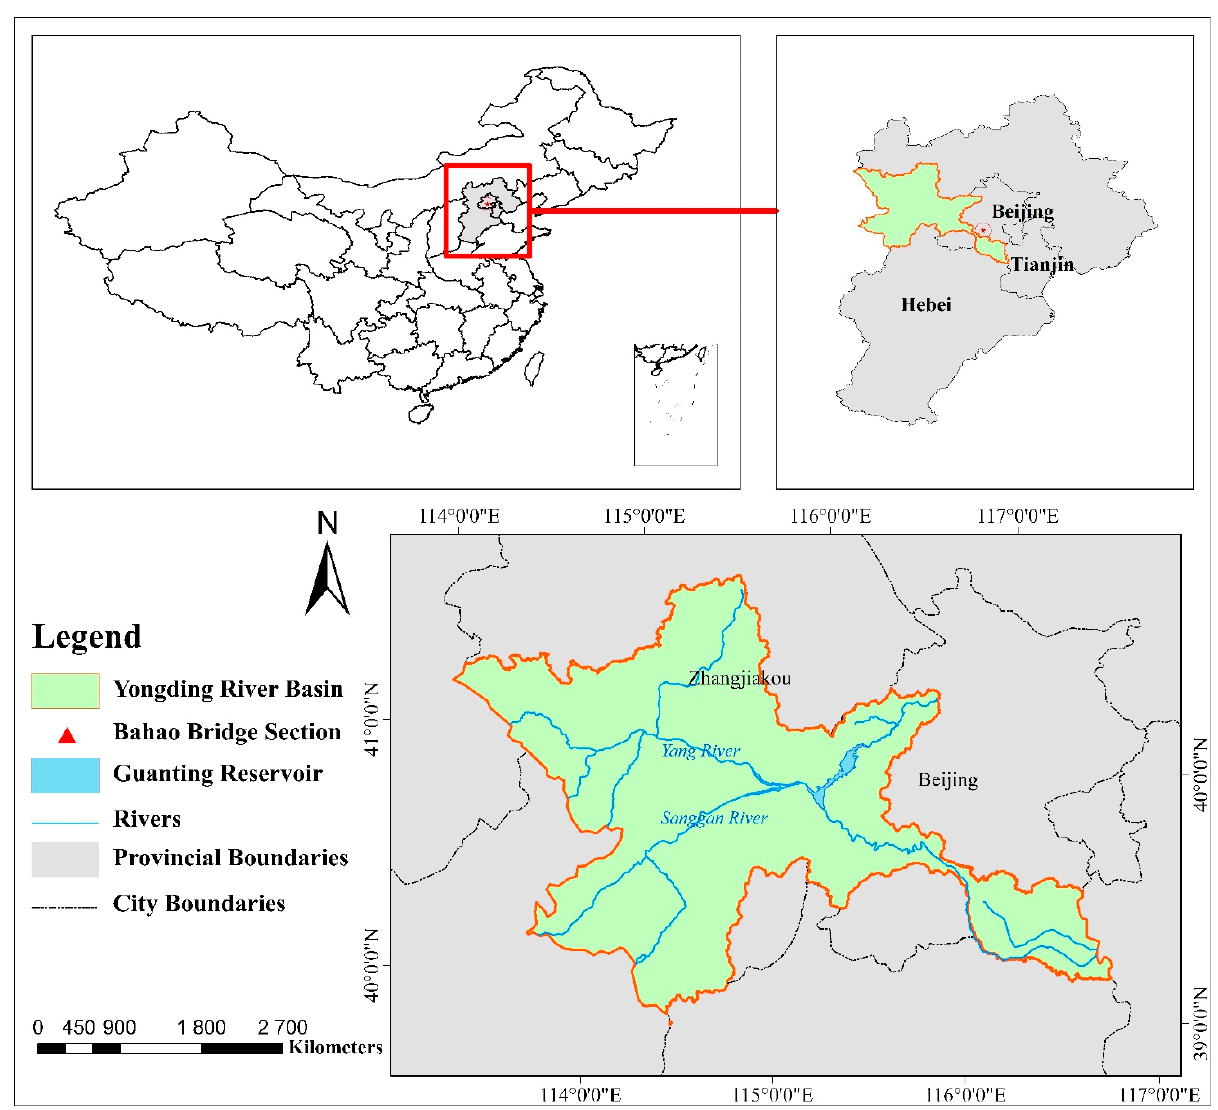
Figure 1. The location of the Bahao Bridge Section in the Yongding River watershed.